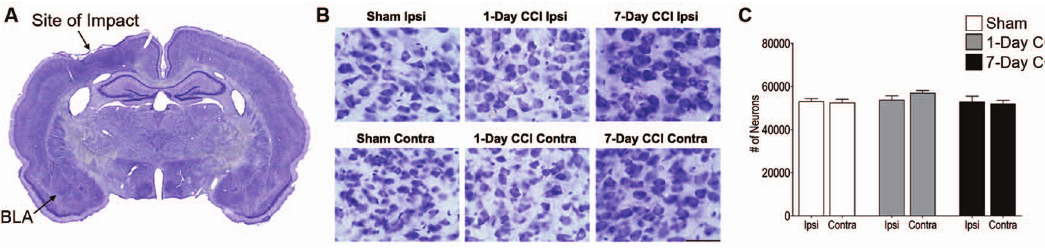
Figure 2. Mild CCI does not cause a significant loss of neurons in the BLA 24 hours or 7 days after injury. (A) Panoramic photomicrograph of Nissl-stained brain slice. Indicated are the sites of impact and the ipsilateral BLA. (B) Representative photomicrographs from Nissl-stained sections showing BLA cells from the ipsilateral (Top) and contralateral (Bottom) sides of sham, 1-day CCI, and 7-day CCI animals, respectively. Total magnification is 630X; scale bar, 50 m m. (C) Group data (mean 6 SE; n=8 for each group) of stereological estimation of the total number of Nissl-stained neurons in the BLA.